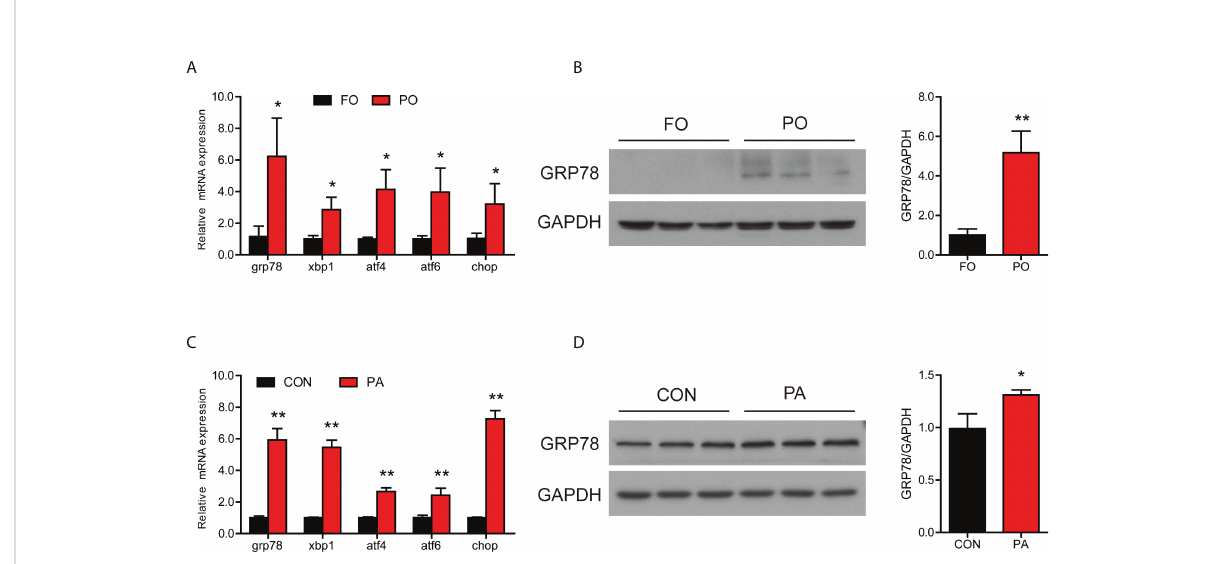
FIGURE 2 Effect of PO or PA treatment on ER stress and UPR pathway in the intestine or intestinal cells of large yellow croaker. (A) Relative mRNA expression of ER stress-related genes in the intestine after different diets (n = 3). (B) Protein level of GRP78 in the intestine after different diets (n = 3). (C) Relative mRNA expression of ER stress-related genes in the intestinal cells after BSA or PA treatment (n = 3). (D) Protein level of GRP78 in the intestinal cells after BSA or PA treatment (n = 3). Results were presented as mean ± standard deviation (SD) and analyzed using independent t -test (* P < 0.05, ** P < 0.01). FO, fi sh oil; PO, palm oil; CON, bovine serum albumin treatment; PA, palmitic acid